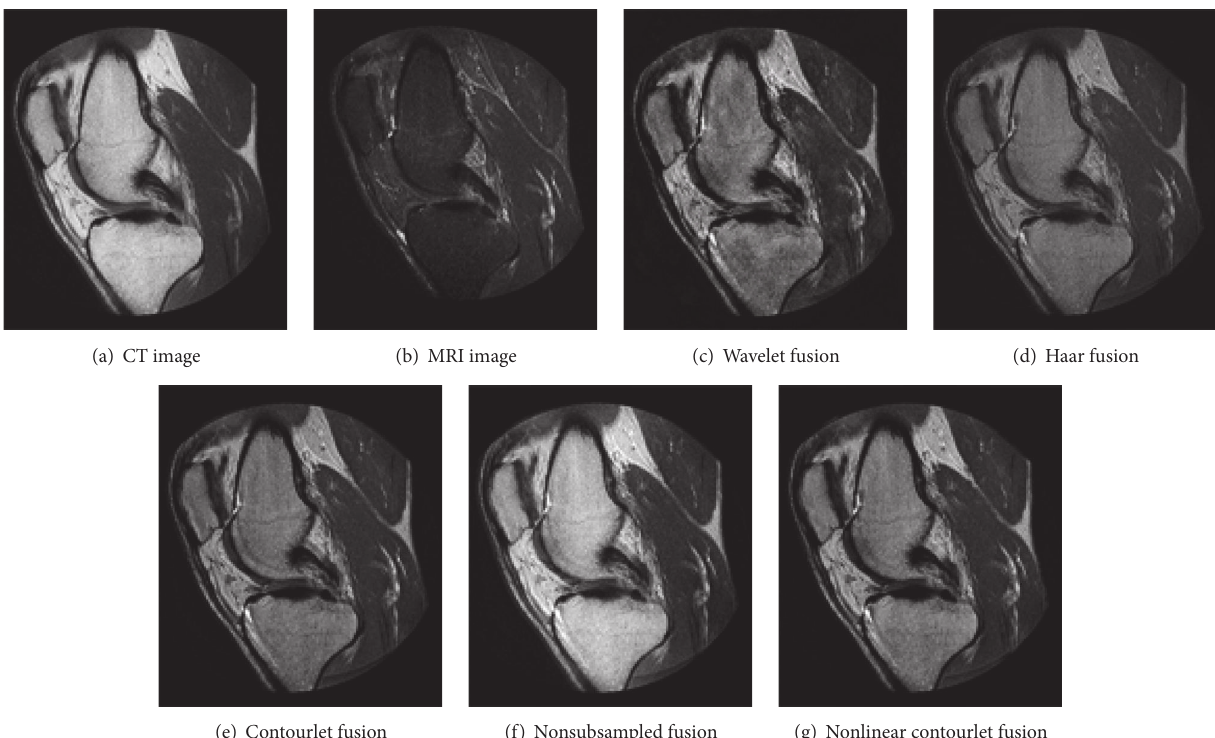
Figure 6: Fusion results’